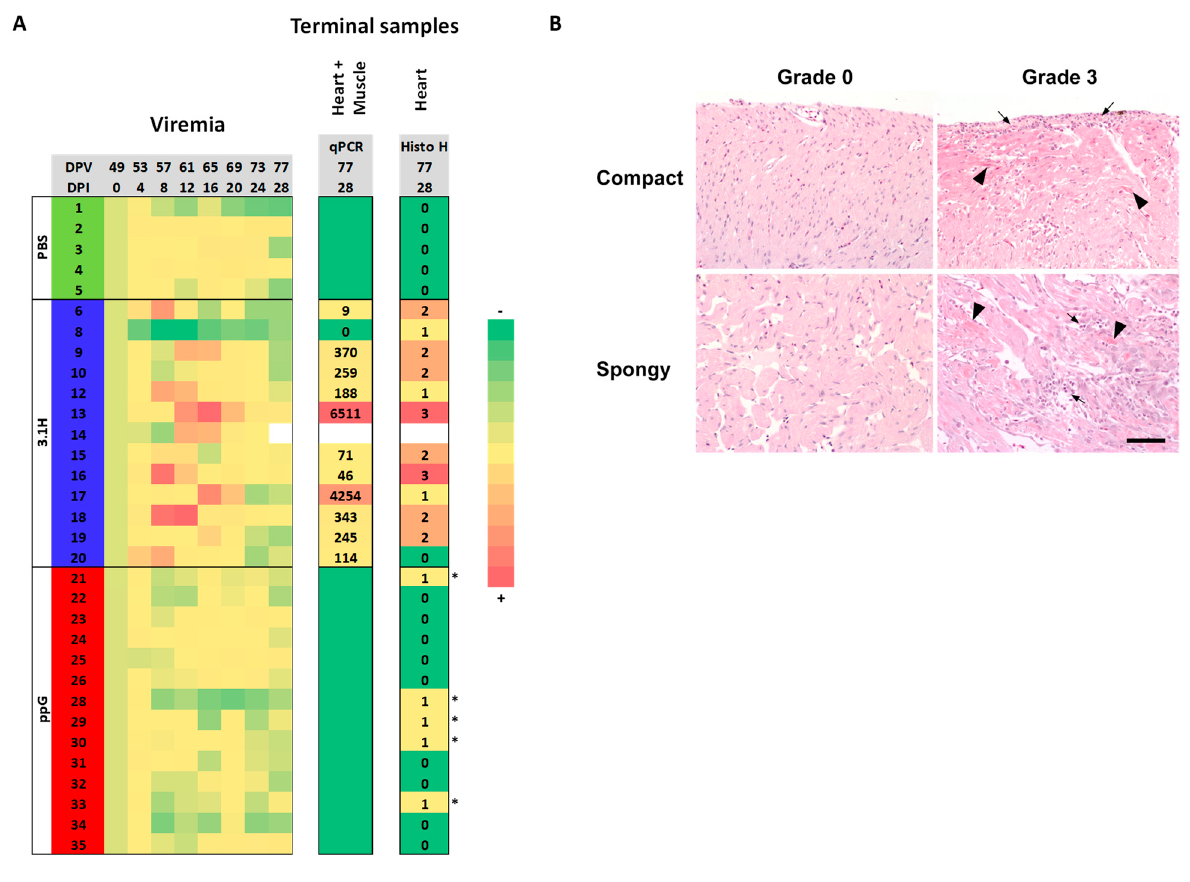
Figure 3. ( A ). Individual SPDv viremia following immersion infection measured by the RTG-P1 method. Fish were injected with PBS (Fish 1–5), 3.1H (empty vector, Fish 6–20) or ppG (SPDv vaccine, Fish 21–30). Data are individual viremia (fish number in the second column) at different days post-infection (DPI) relative to the individual’s viremia at 0 dpi and are represented as a heatmap. The time scale in relation to days post-vaccination (DPV) is also indicated. The column named “qPCR” gives the relative level of viral load assessed by quantitative RT-PCR in a pool of heart and muscle tissue RNA from the terminal sampling point (DPI 28). The column labelled “Histo H” indicates the histopathological score in the heart at dpi 28. “*” indicates a non-inflammatory lesion. ( B ). Compact and spongy myocardium: Histological images of samples from group 3.1H for animals F20 (Grade 0, left) and F13 (Grade 3, right) at terminal sampling date (dpv 77/ dpi 28). These samples were chosen to illustrate the differences between the two extremes of the histological presentation (i.e., 0 and 3). Please note that intermediate grades vary in the frequency and severity of the lesions, but not in the specific patterns associated with these lesions. Briefly, the tissue in grade 0 is histologically normal, while the tissue in grade 3 features cardiomyocyte necrosis/degeneration (black arrowheads) and inflammatory infiltration by mononuclear cells (black arrows). These patterns are visible in both the compact and spongy layers. Haematoxylin and Eosin, ×200. Scale bar = 100